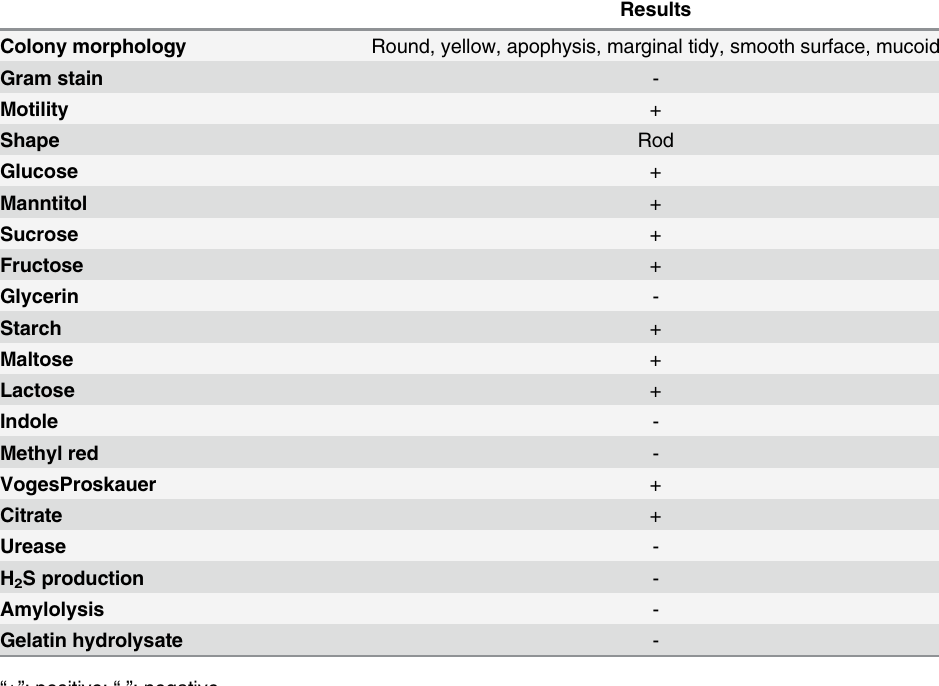
Table 1. Morphological and biochemical characteristics of strain SD8.